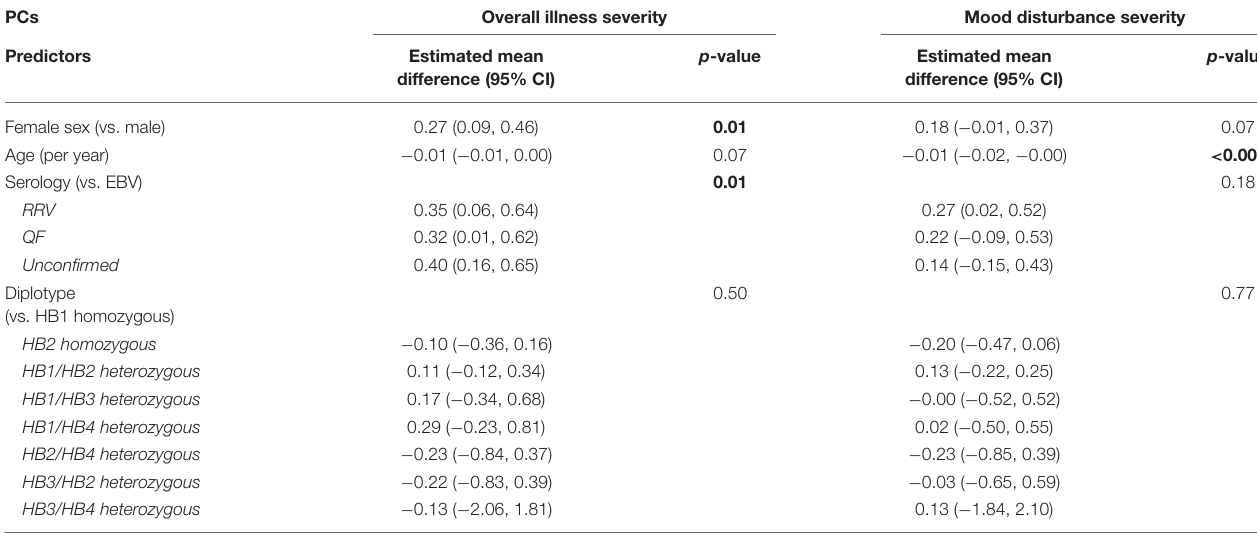
TABLE 2 | Univariate model for overall illness severity and mood disturbance endophenotype during the acute illness phase (baseline).